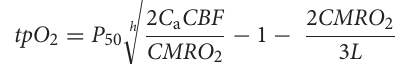
Frontiers in Neuroscience |